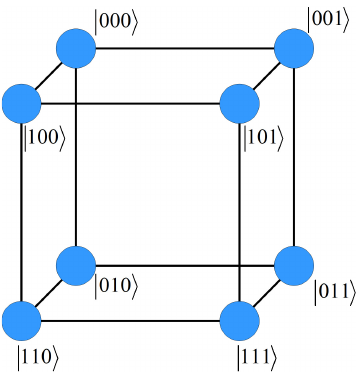
Figure 6. Mapping 4-qubit quantum walk onto a 3D